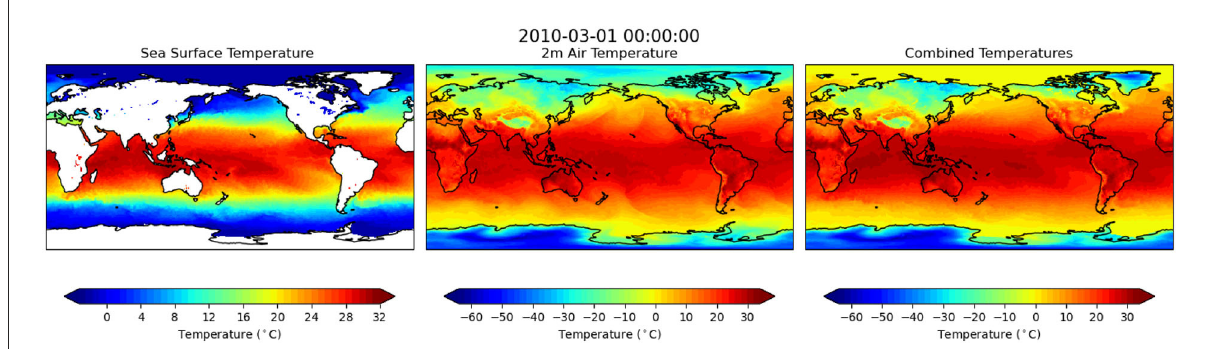
FIGURE1 An illustration of the ERA5 monthly mean sea surface temperature (SST), 2-meter air temperatures, and the combined temperatures where the 2-meter air temperature is used only over the land surface during March 2010. The correlation coefficient between the SST and 2-meter air temperatures, computed over the ocean only, is 0.92 in this